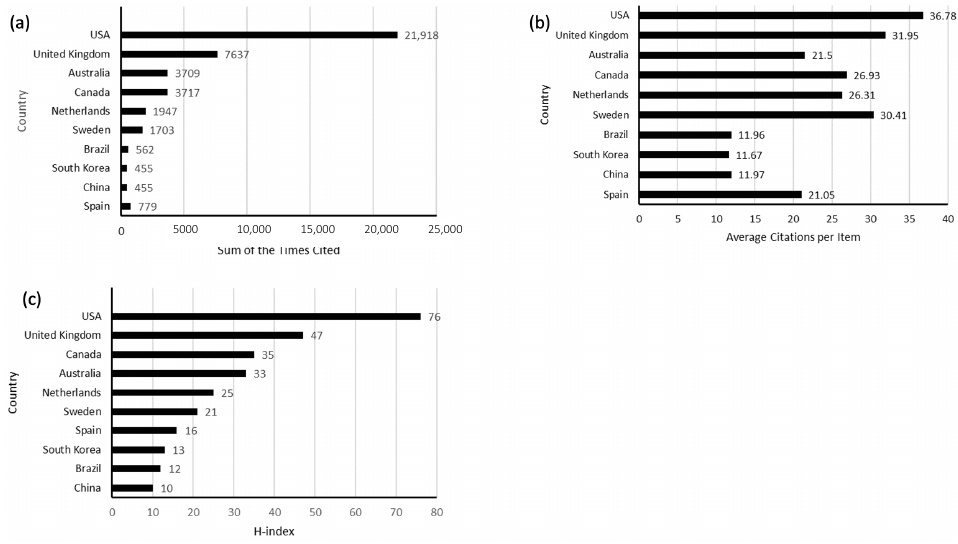
Figure 3. ( a ) The top 10 countries of total citation frequency; ( b ) The top 10 countries of average citations for each article; ( c ) The top 10 countries of the h-index. Table 1. The contributions in publications of countries.